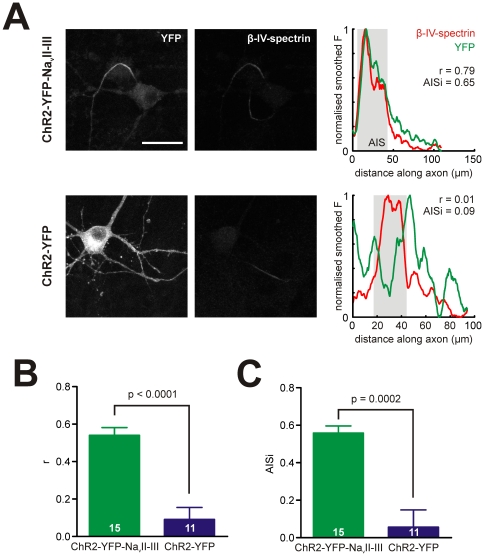
The sodium channel loop NavII-III targets ChR2 to the AIS.A) Example images (left) of neurons expressing ChR2-YFP-NavII-III (top, note background fluorescence revealing the soma of a non-transfected neuron in the YFP channel, with this cell's AIS also clear in the βIV-spectrin channel), or ChR2-YFP (bottom), co-stained for βIV-spectrin. Scalebar, 25 µm. Plots (right) show normalised YFP and βIV-spectrin fluorescence along the axon, with associated AIS localisation indices. Grey box shows AIS location. B, C) Mean correlation r (B) between YFP and βIV-spectrin fluorescence, and mean AISi (C; see text) showing AIS localisation of ChR2-YFP-NavII-III. Numbers in bars show n for each group; error bars show SEM; p values report results of t-tests.